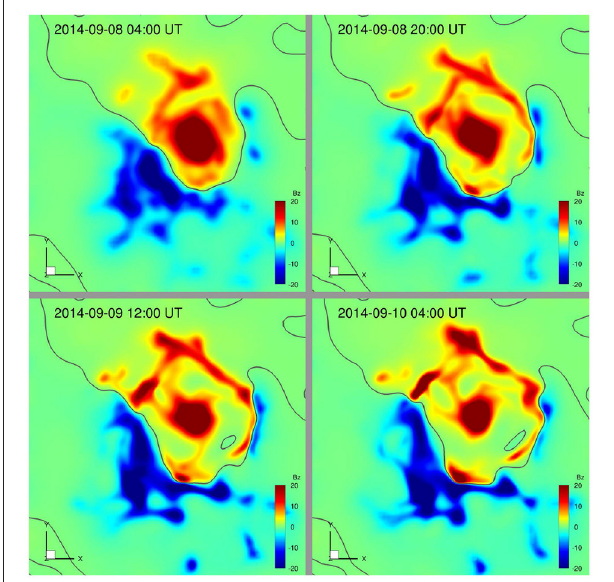
FIGURE 8 | Evolution of magnetic flux distribution on the bottom surface in the simulation, shown for 4 snapshots of the same times shown in Figure 5